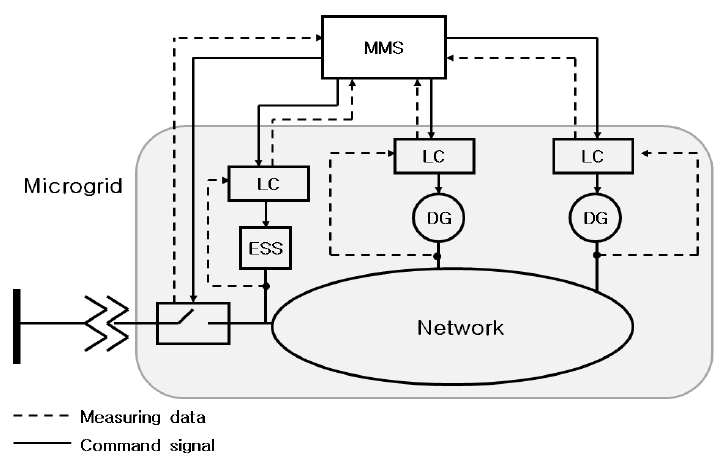
Figure 1. The hierarchical control structure of microgrid.